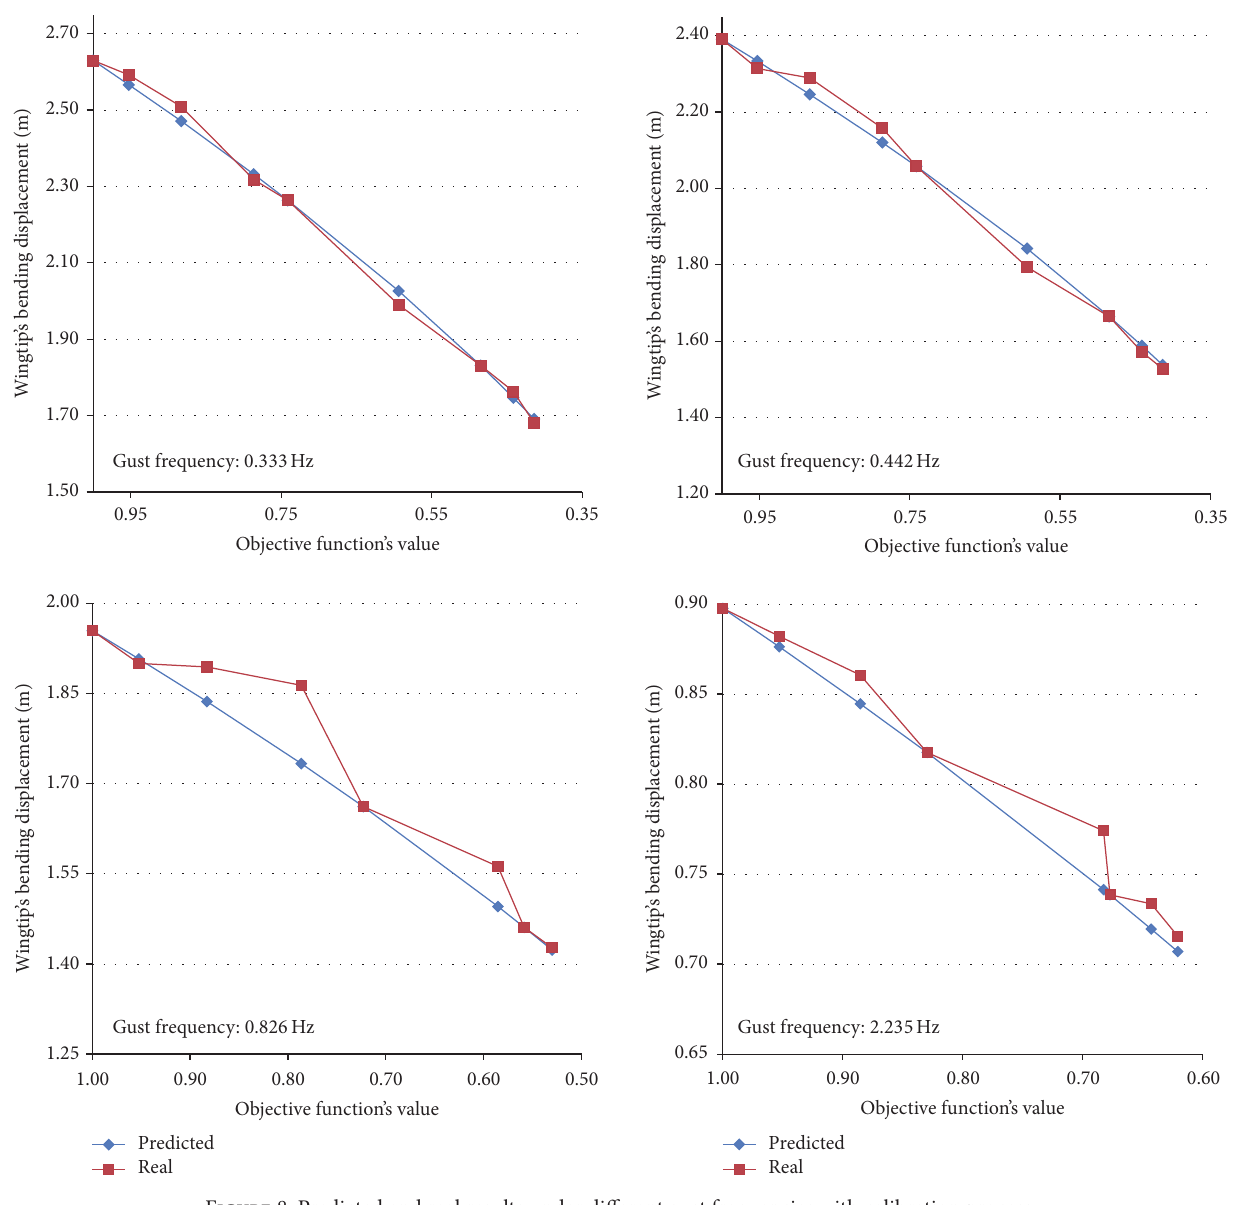
Figure 8: Predicted and real results under different gust frequencies with calibration process.